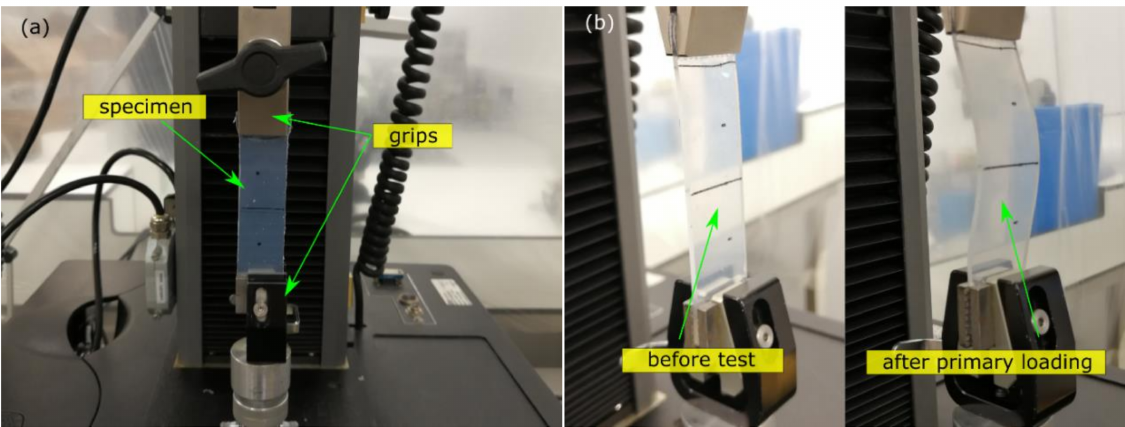
Figure 2. Uniaxial tension test: ( a ) testing setup; ( b ) shapes of specimen before test and after primary